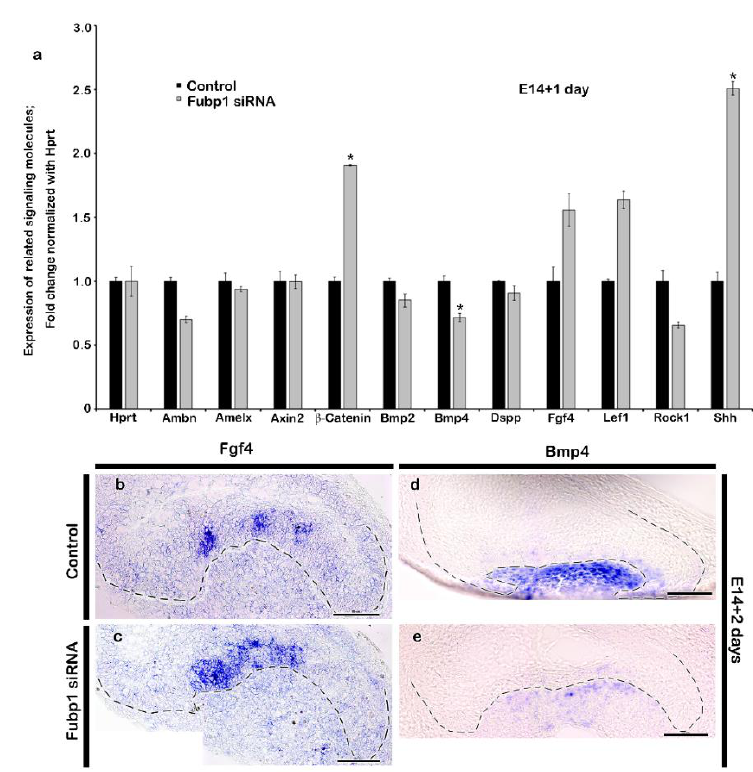
Figure 4. Expression patterns of tooth related signalling molecules after Fubp1 knock-down. Knock-down of Fubp1 results altered expression of tooth development related signalling molecules including Bmp , Wnt , Shh and Fgf4 as detected by qPCR ( a ) and section in situ hybridization ( b – e ). Especially, Bmp2 , Bmp4 and Rock1 are downregulated, whereas β -catenin, Fgf4 , Lef1 and Shh are upregulated. Enamel- and dentin-specific signalling molecules: Ambn , Amelx and Dspp are downregulated in Fubp1 knock-down tooth. Similarly, section in situ hybridization shows increased expression of Fgf4 and decreased expression of Bmp4 along enamel and mesenchyme of the Fubp1 siRNA transfected tooth germ respectively compared with the control ( b – e ). * indicates p < 0.05. Scale bars: 50 µ m ( b – e